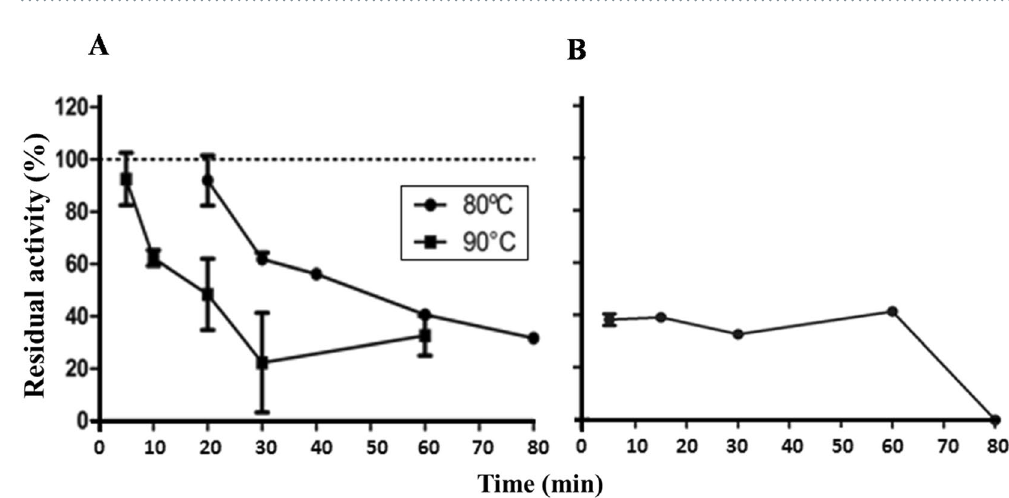
Figure 8. Thermostability at 80 and 90 °C in Acremonium zeae B extracts ( A ) and at 80 °C in Kluyveromyces marxianus extracts ( B ). The bars correspond to the standard deviations of the means (n = 3). Data expressed in terms of residual activity consider the activity value of the extract at zero incubation time as